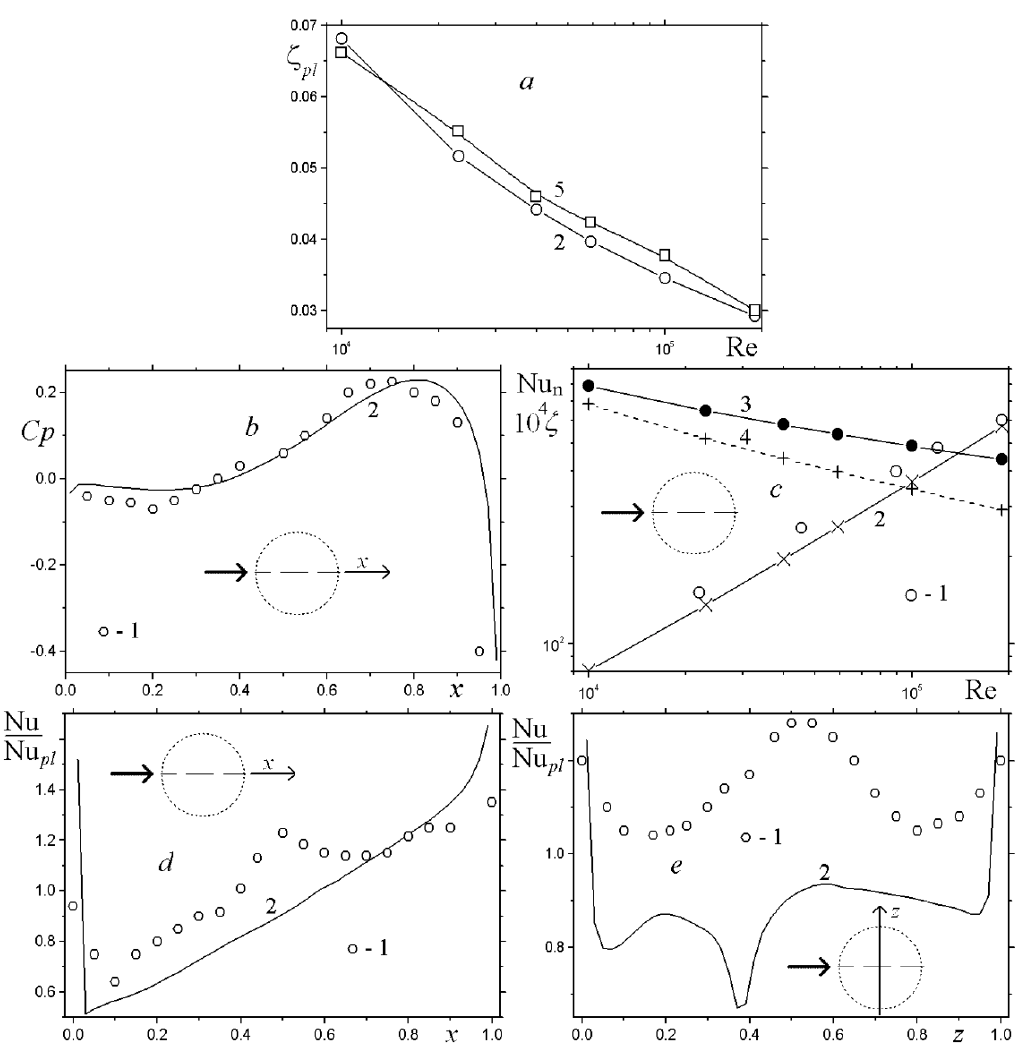
Figure 5. Verification: the comparison of the experimental data [10] with the numerical predictions of flow and heat transfer characteristics in the narrow channel with a spherical dimple (dimple spot heating at q = const): 1, 3—experiment [10]; 2, 4—calculation; 3, 4—hydraulic losses; 5—data [59]. ( a ) ζ pl (Re); ( b ) Cp ( x ); ( c ) Nu n (Re), 10 4 ζ (Re); ( d ) Nu/Nu pl ( x ); ( e ) Nu/Nu pl ( z )